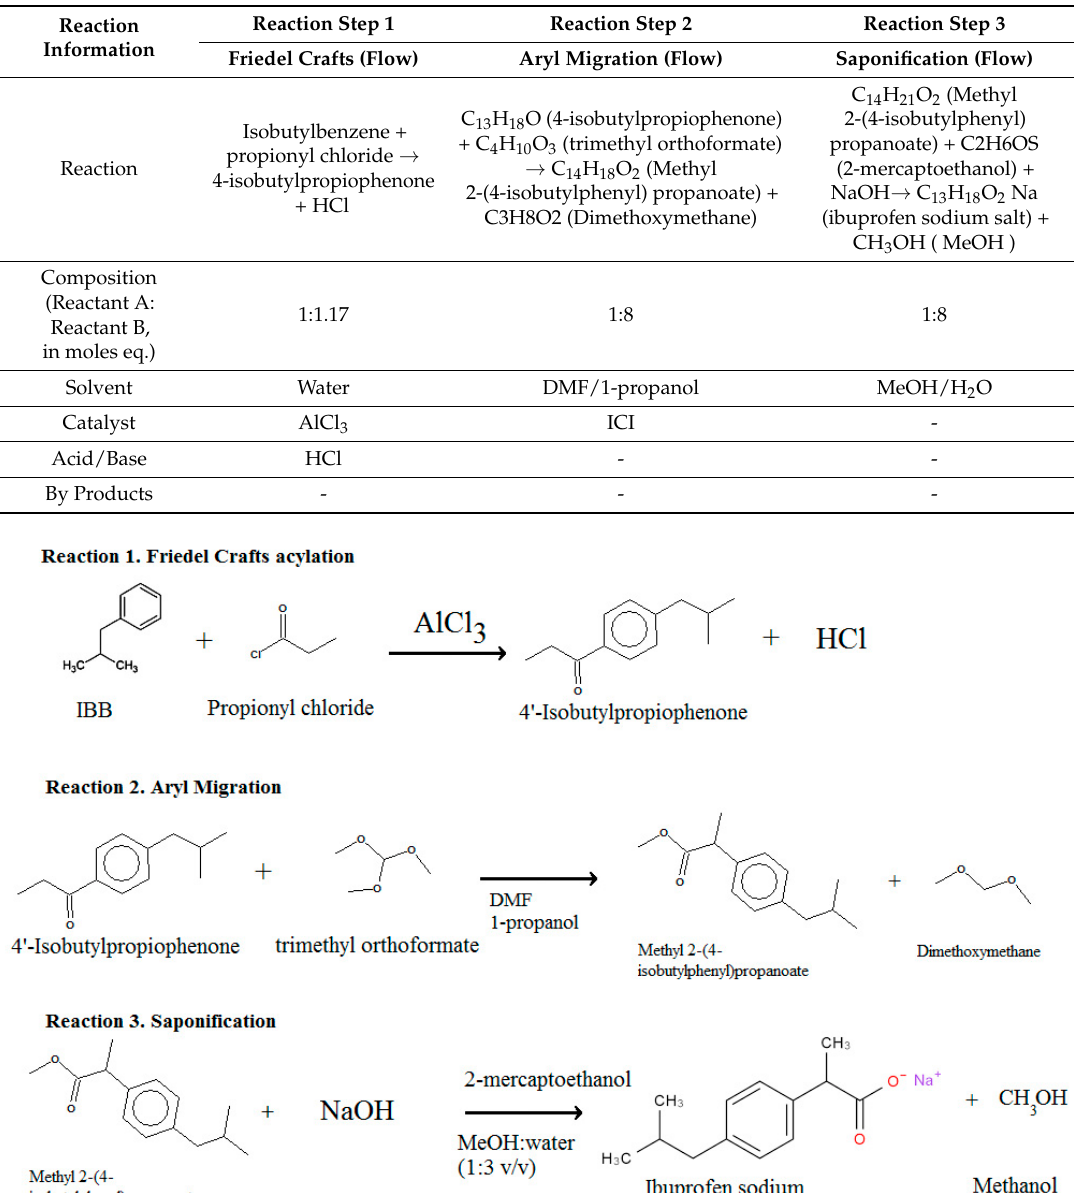
Table 12. Retrieved reaction information from the database.